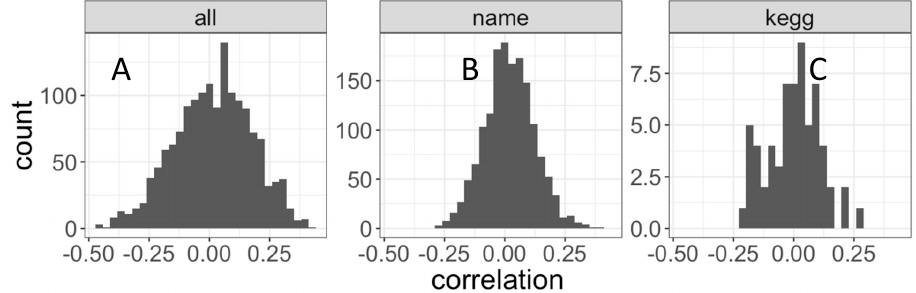
Figure 2. BAL and Plasma comparison using distribution of Pearson’s correlation between BAL and plasma. All compounds (left), only annotated compounds (middle), or annotated compounds with KEGG identifiers (right). Mean correlation and t-test P -values are mean = 0.015, P = 1.7 × 10 − 4 ( A ), mean = 0.021, P = 4.7 × 10 − 15 ( B ) and mean = 1.1 × 10×, P = 0.94 ( C ). The set of all compounds passing the <20% missingness preprocessing filter and annotated with HMDB identifiers was equivalent to the corresponding KEGG set, and no separate distribution for HMDB is shown.